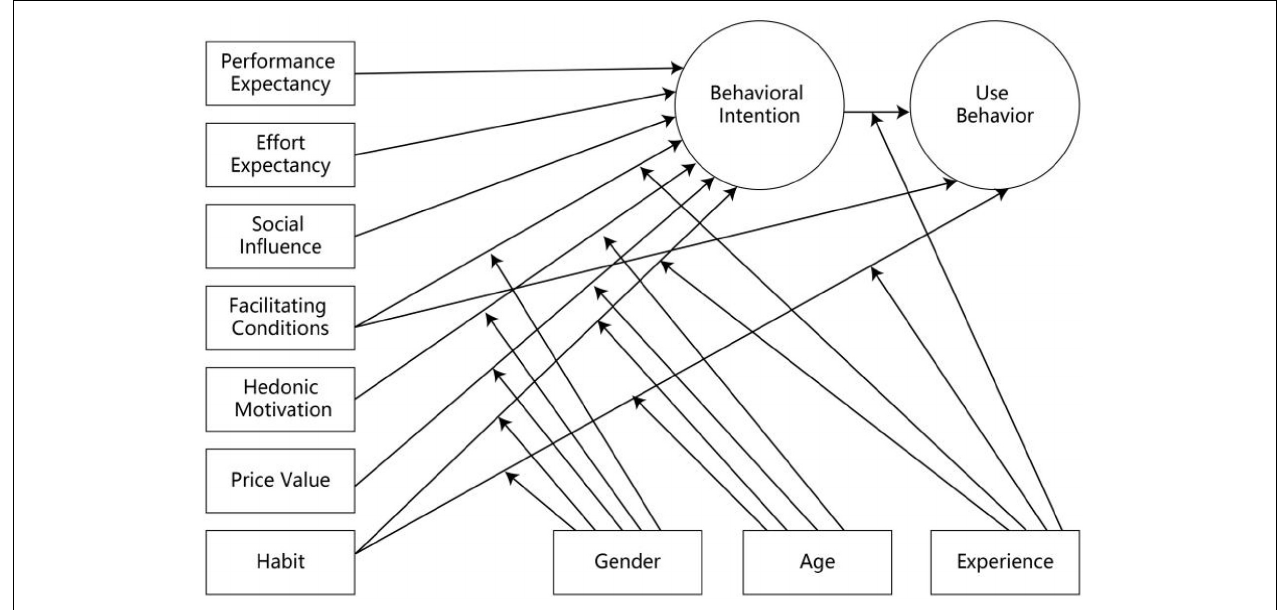
FIGURE 2 | UTAUT-2 MODEL (Venkatesh et al.,